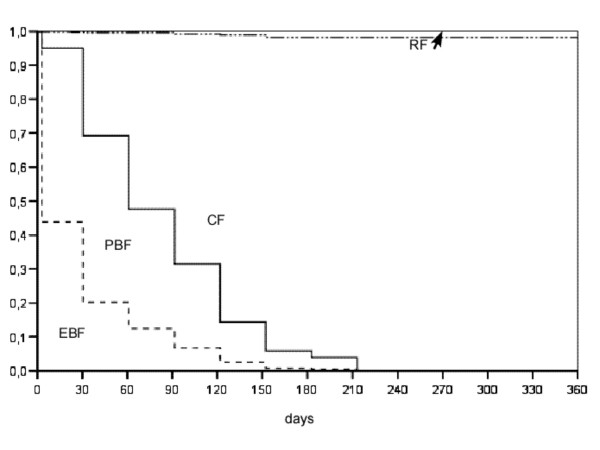
The proportion being exclusively breastfed (EBF), predominantly breastfed (PBF), complementary fed (CF) and replacement fed (RF) according to the recall since birth.